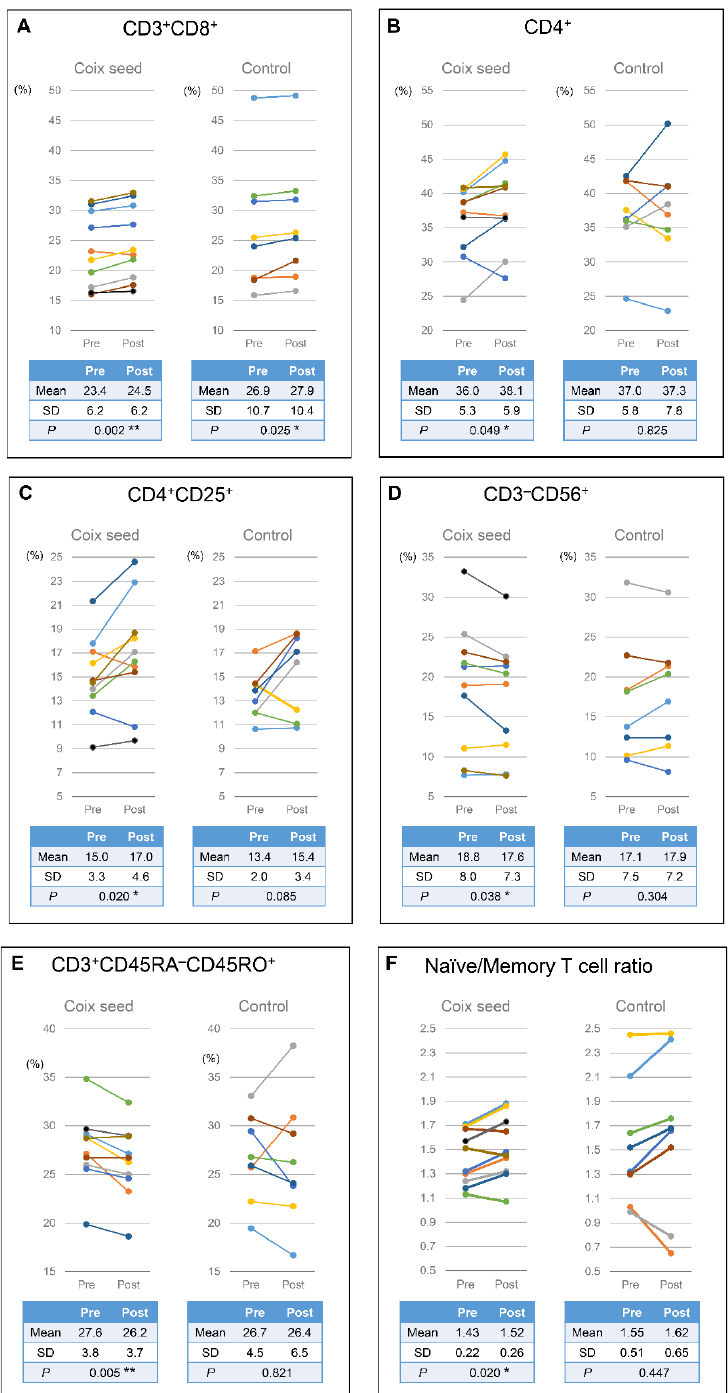
Figure 5. Relative changes in the peripheral lymphocyte subsets as identified in each participant before and after (Pre and Post) the intervention; ( A ) killer T cells (CD3 + CD8 + ); ( B ) helper T cells (CD4 + ); ( C ) regulatory T cell (CD4 + CD25 + ); ( D ) natural killer T cells (CD3 − CD56 + ); ( E ) memory T cells (CD3 + CD45RA − CD45RO + ); and ( F ) the naïve/memory T cell ratio. After one week of coix seed consumption, the relative peripheral CD3 + CD8 + (killer T cell), CD4 + (helper T cell), and CD4 + CD25 + (Treg cell) percentages, as well as the naïve/memory T cell ratio increased, and the relative peripheral CD3 − CD56 + (NK cell) and CD3 + CD45RA − CD45RO + (memory T cell) percentages decreased in coix seed (CS) group. In contrast, significant change was only seen in the relative percentage of killer T cells (CD3 + CD8 + ) in control (CN)